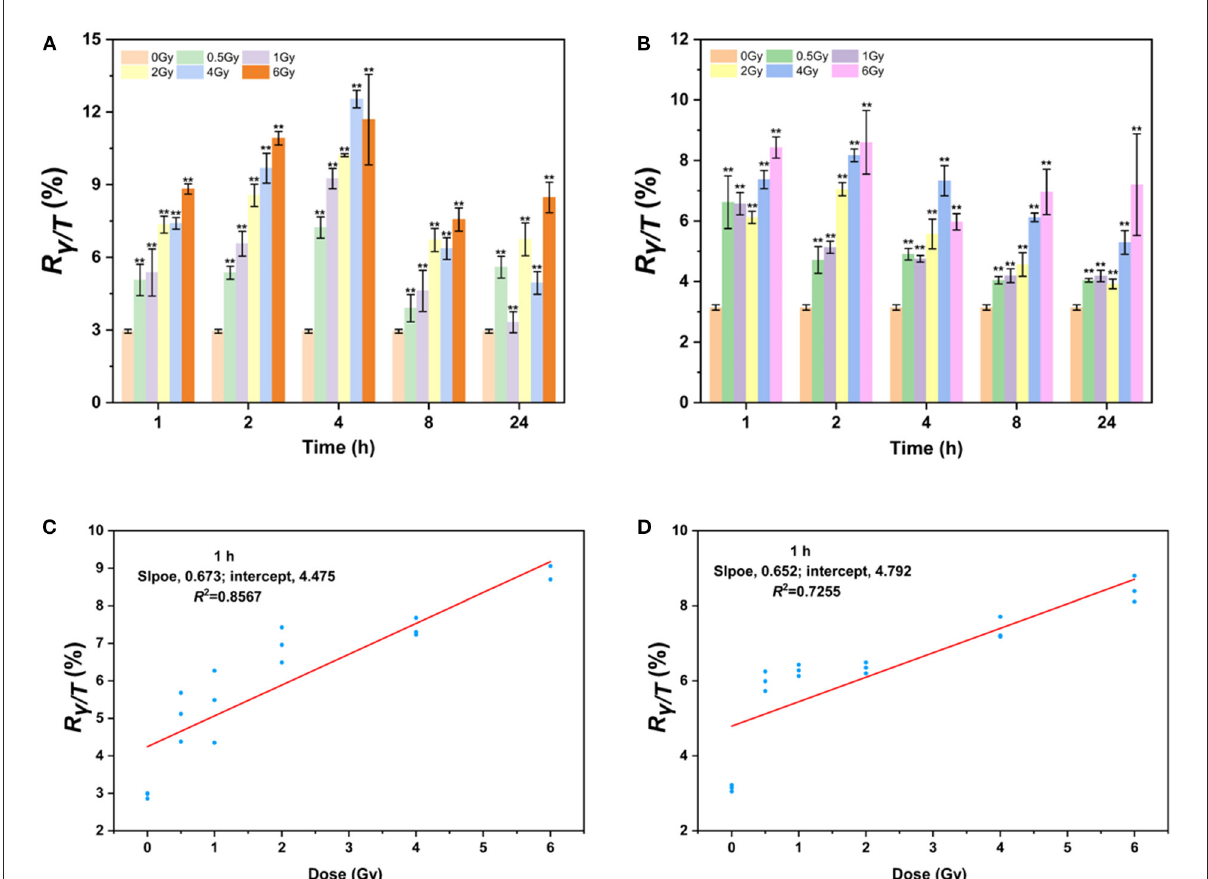
FIGURE3 γ -H2AX response after low-LET proton and high-LET heavy ion exposure in AHH1 cells. (A) γ -H2AX change in 0.5–6Gy proton-irradiated AHH1 cells at various time points, (B) γ -H2AX change in 0.5–6Gy heavy ion-irradiated AHH1 cells at various time points, (C) linear regression plot of γ -H2AX levels in proton-irradiated AHH1 cells vs. doses at 1h post-exposure, and (D) linear regression plot of γ -H2AX levels in heavy ion-irradiated AHH1 cells vs. doses at 1h post-exposure ( n ≥ 3, mean ± SD, ** p ≤